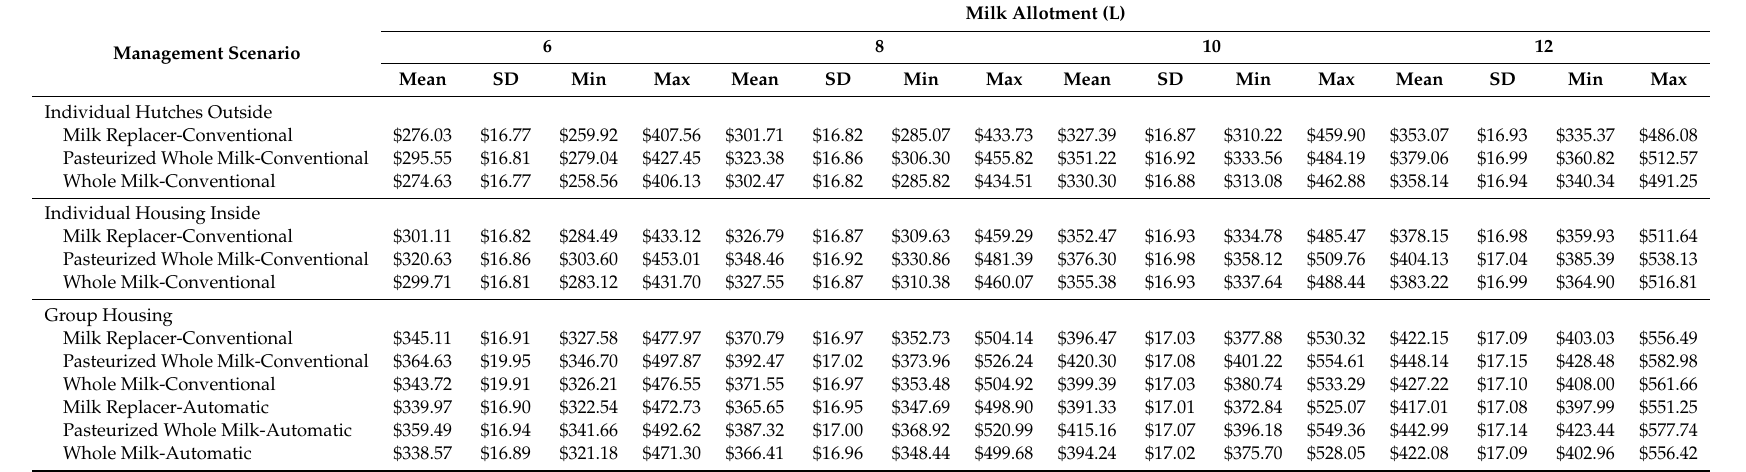
Table 7. Total cost mean, SD, min and max of each management pathway under 6, 8, 10, and 12 L milk